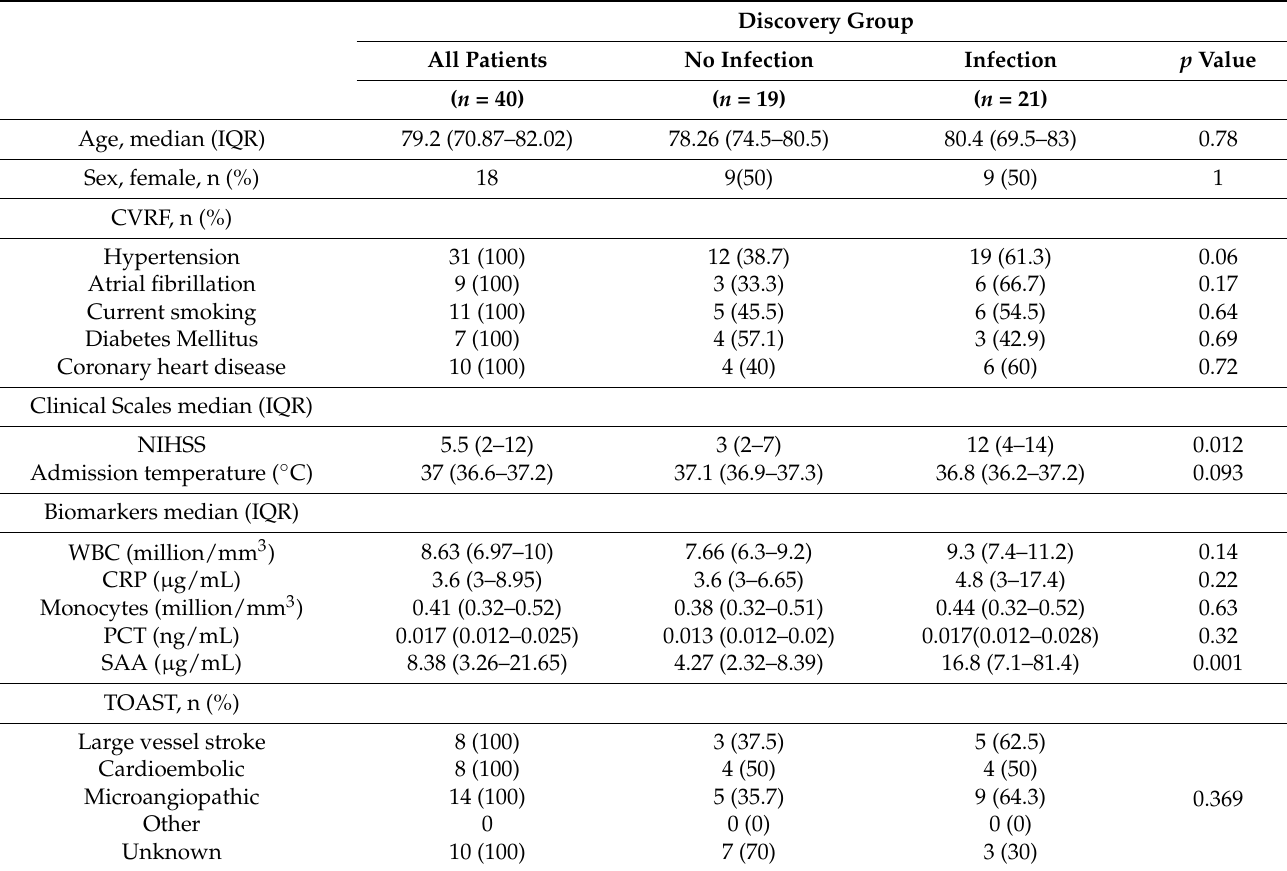
Table 1. Demographic characteristics of the discovery subgroup including 19 non-infected and 21 infected patients.